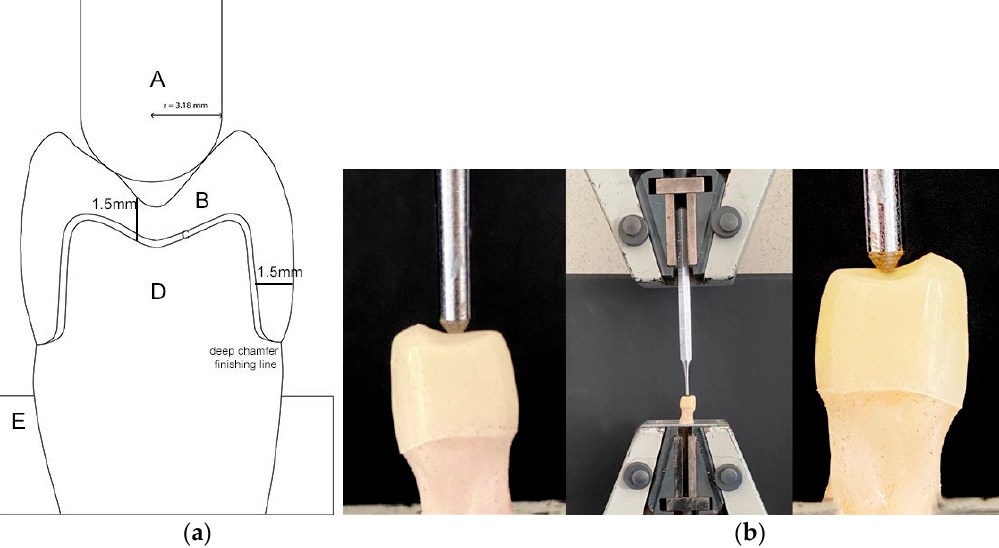
Figure 1. ( a ) Graphical representation of sample preparation: ( A ) tungsten carbide pilot punch with a radius of 3.18 mm; ( B ) Zls crown; ( C ) cement; ( D ) tooth abutment replica of resin composite; ( E ) specimen holder of methacrylic resin; ( b ) an explanatory image of the samples during the test